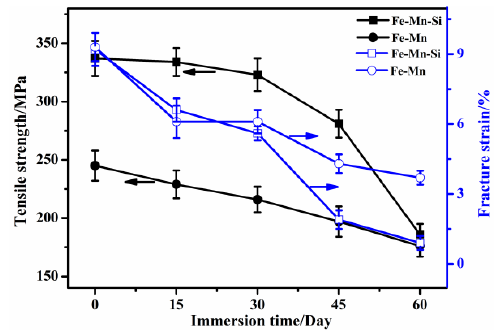
Figure 4. The evolution of the tensile strength and fracture strain of the sintered Fe–Mn-based alloys as a function of immersion time in SBF solution.